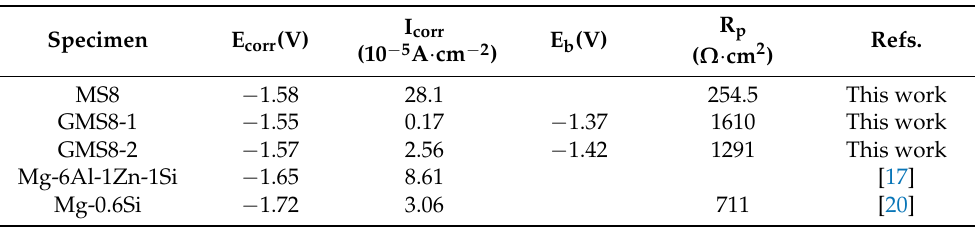
Table 1. Electrochemical parameters derived from the polarization curves of the specimens in PBS at 37 ◦ C.